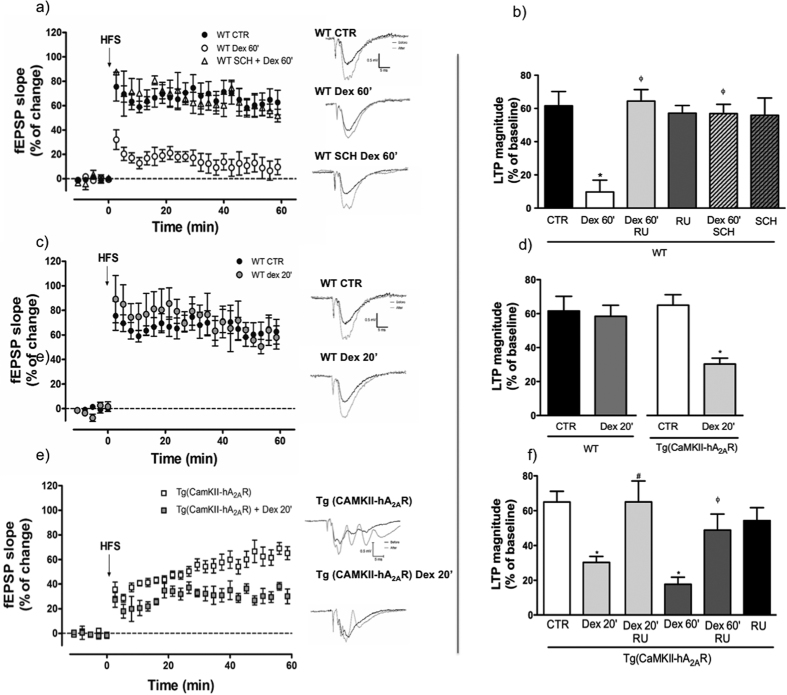
Dexamethasone induced deficits in synaptic plasticity are prevented by adenosine A2A receptor (A2AR) blockade and exacerbated by A2AR overexpression.High frequency stimulation (HFS: 100 Hz, 1s) was used to evaluate synaptic plasticity in hippocampal slices. (a) Incubation of slices from WT rats with dexamethasone (100 nM) for 1 h decreases LTP magnitude an effect prevented by the A2AR antagonist SCH58261 (50 nM). (b) Magnitude of the effects of dexamethasone, RU486 (100 nM) and SCH58261 (n = 3–8) in hippocampal slices from WT rats. Results are presented as mean ± SEM of n experiments analyzed using a one-way ANOVA followed by a Bonferroni post hoc test. *P < 0.05 compared to CTR; ϕP < 0.05 compared with dexamethasone 60 min. (c) Incubation of slices with dexamethasone (100 nM) for 20 minutes has no effect on LTP magnitude in WT animals (n = 3–8), whereas (e) in Tg(CaMKII-hA2AR) animals is sufficient to induce a significant decrease in LTP magnitude (n = 6–9). (d) Bar plots of the effects of dexamethasone and (f) the prevention of these effects by the GR antagonist RU486 (n = 3–9). Results are presented as mean ± SEM of n experiments analyzed using an unpaired t-test for comparisons between WT and Tg(CaMKII-hA2AR) and one-way ANOVA followed by a Bonferroni post hoc test for drug effects.*P < 0.05 compared to control, #P < 0.05 compared with dexamethasone 20 min, ϕP < 0.05 compared with dexamethasone 60 min.